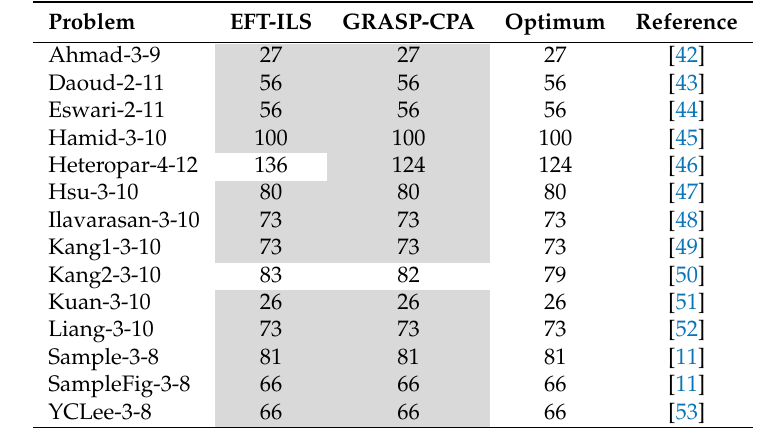
Table 9. Small synthetic benchmark instances best results found by EFT-ILS and GRASP-CPA over 100 independent runs. Light gray emphasizes the best